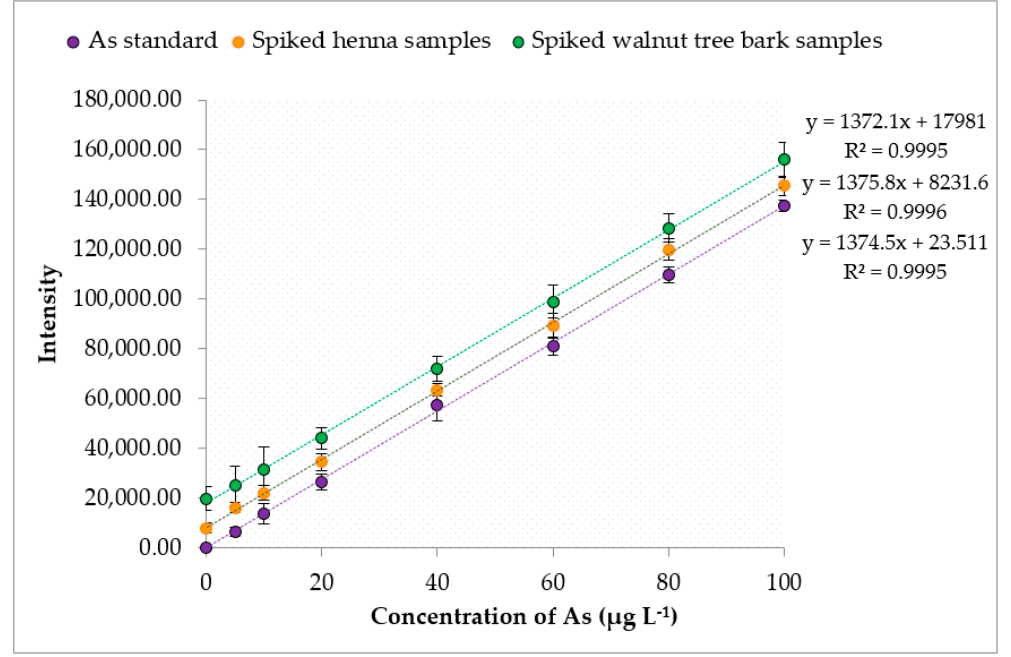
Figure 3. Recoveries of As from spiked henna and walnut tree bark samples.